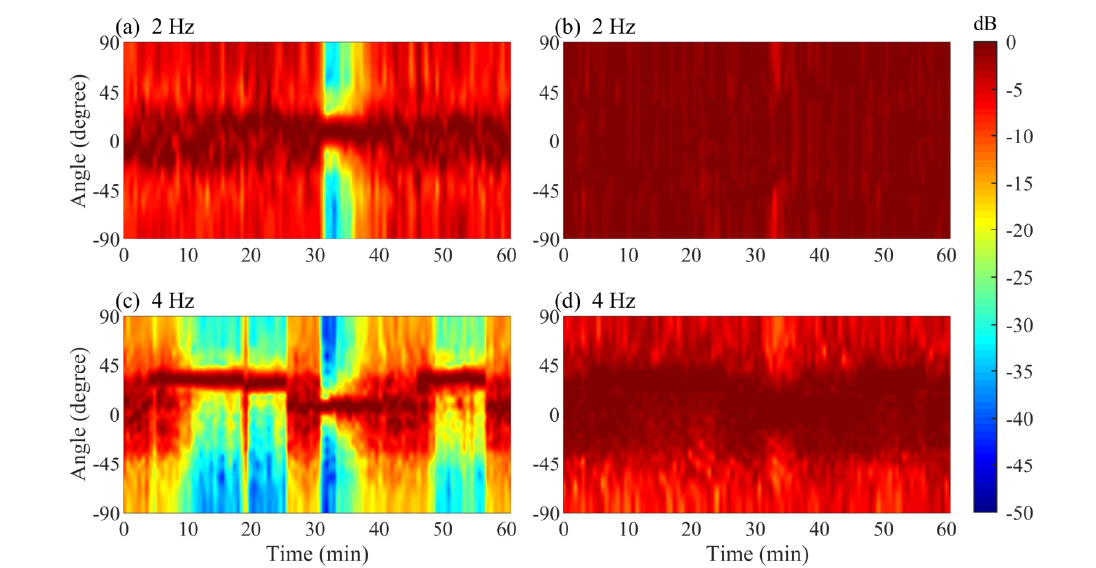
Figure 4. Beamforming results. ( a , b ) show the beamforming energy distribution of 2 Hz; ( c , d ) show the beamforming energy distribution of 4 Hz; ( a , c ) show the beamforming energy distribution of the original wavefield; ( b , d ) show the beamforming energy distribution of the filtered wavefield using the adapted eigenvalue-based